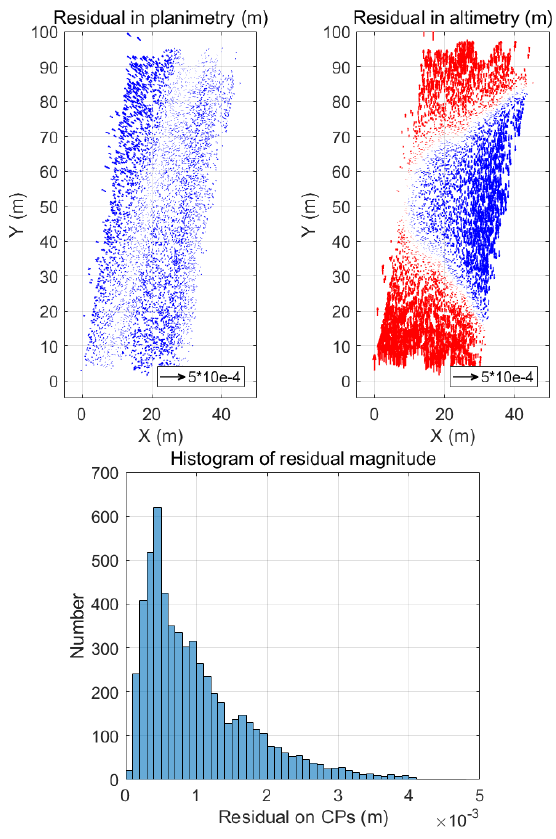
Figure 8. The spatial distribution of residuals on CPs when the variation of focal length is not taken into account. Upper left : residual on planimetry, vector direction and magnitude represent residual direction and magnitude, respectively. Upper right : residual on altimetry, vector direction and color represent the sign of residuals, upward red means positive, downward blue means negative; vector magnitude represents residual magnitude. The first two images share the same scale. Bottom : histogram of residual magnitude.